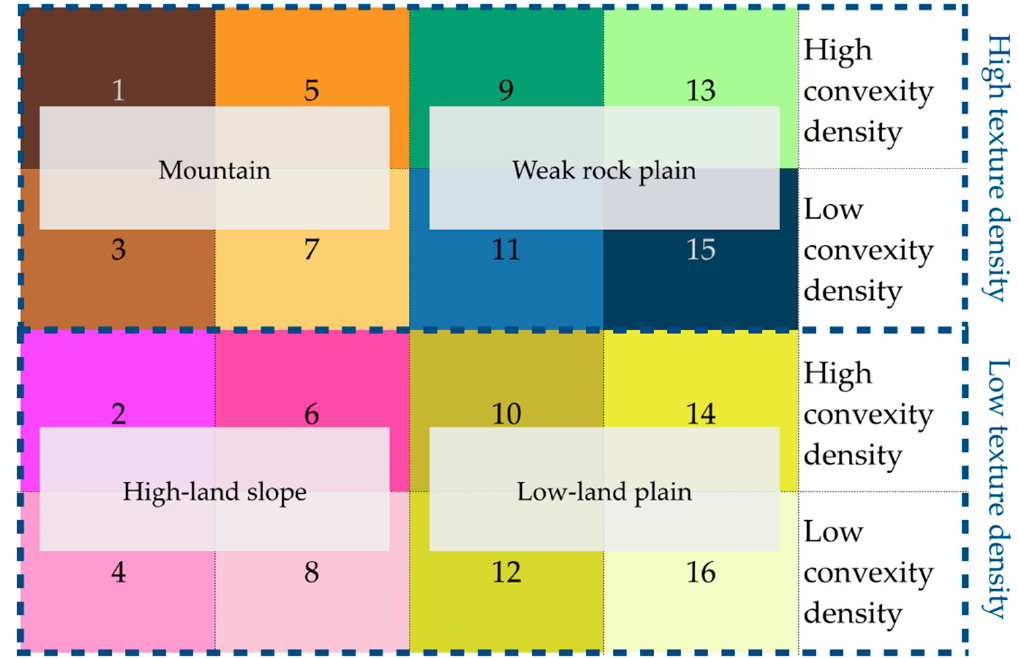
Figure 3. Major geomorphology groups.